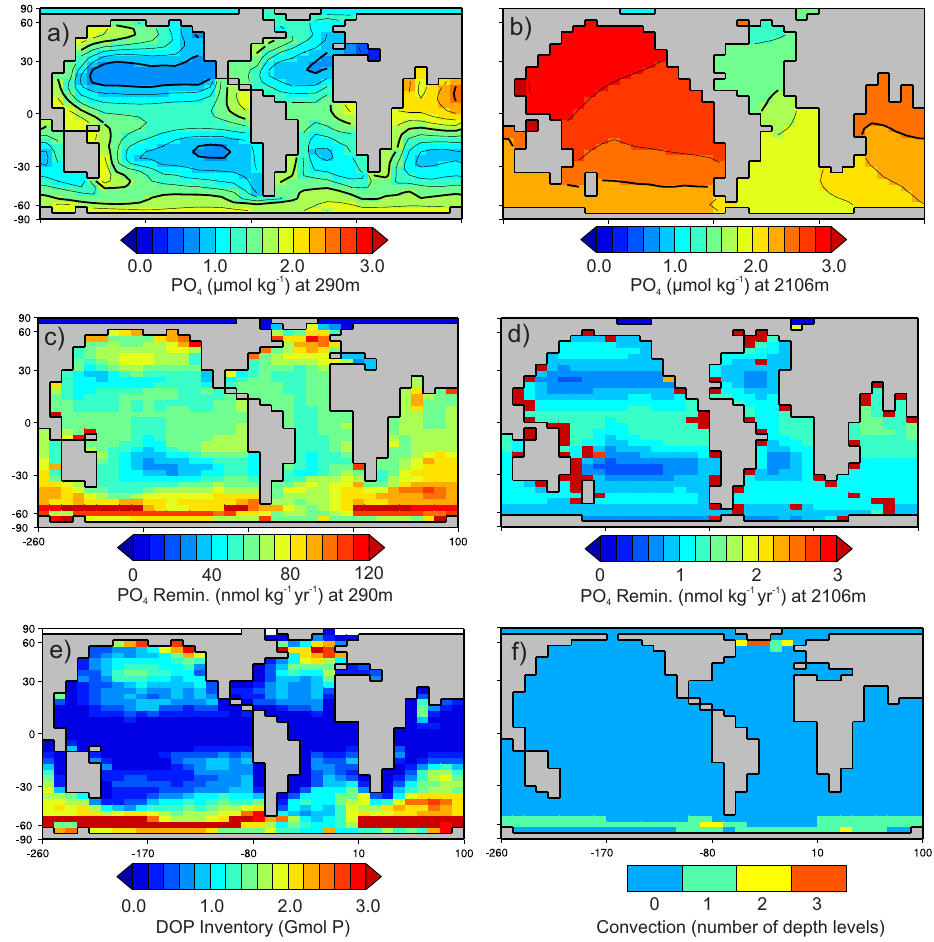
Figure 3. The synthetic tracer data set used for transport matrix inversions. (a) [PO 4 ] (µmolkg − 1 ) at 290 and (b) 2106m. (c) The total annual remineralisation flux of PO 4 (nmolkg − 1 yr − 1 ) at 290 and (d) 2106m. (e) The water-column-integrated inventory of phosphorus in dissolved organic matter in the ocean interior (molP). (f) A measure of the convection occurring in a water column in one model year (unitless). Higher values indicate the number of vertical levels involved in convection in the model, i.e. stronger